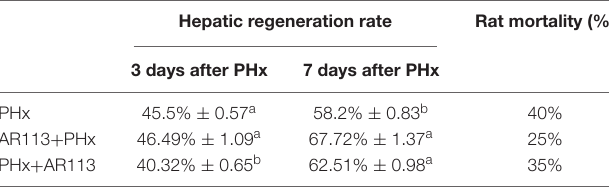
TABLE 1 | The hepatic regeneration rate and rat mortality after PHx. Hepatic regeneration rate Rat mortality (%)